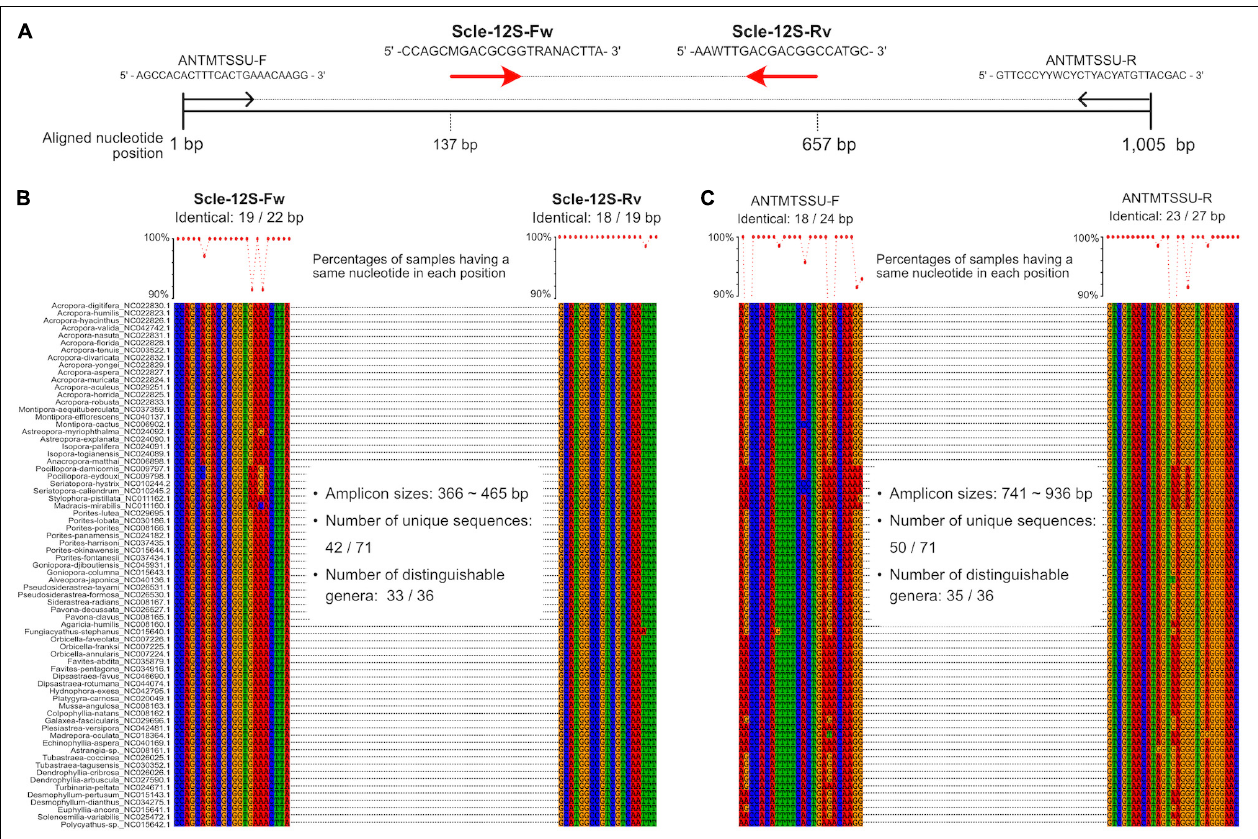
FIGURE 1 | Development of universal primer pairs, Scle-12S-Fw and Scle-12S-Rv, to amplify scleractinian 12S rRNA genes. (A) Schematic representation of primer sequences, positions of primer binding sites in aligned 12S rRNA genes, and comparisons with previously reported universal primers (ANTMTSSU-F and ANTMTSSU-R) (Chen and Yu, 2000). Positions of the designed primers (Scle-12S-Fw and Scle-12S-Rv) are shown with red arrows. (B) Nucleotide sequence alignments of expected Scle-12S-Fw and Scle-12S-Rv primer binding sites among the 71 scleractinian mt genomes. (C) Nucleotide sequence alignments of expected ANTMTSSU-F and ANTMTSSU-R primer binding sites among the 71 scleractinian mt genomes. Numbers of identical nucleotides in primer binding sites among the 71 scleractinians are shown, and percentages of samples having the same nucleotide in each primer position are shown in a line graph (more than 90% are shown as